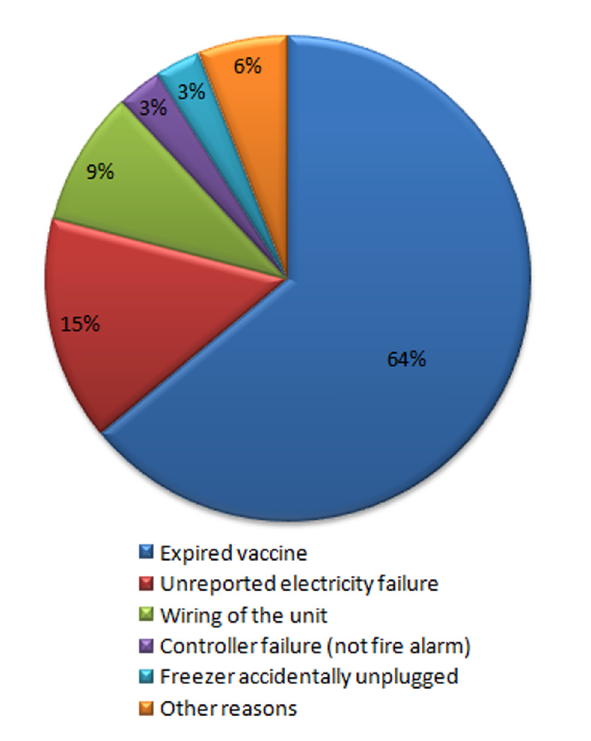
2. Reasons for the destruction of immunobiological products in 2008 and 2009, in Bauru